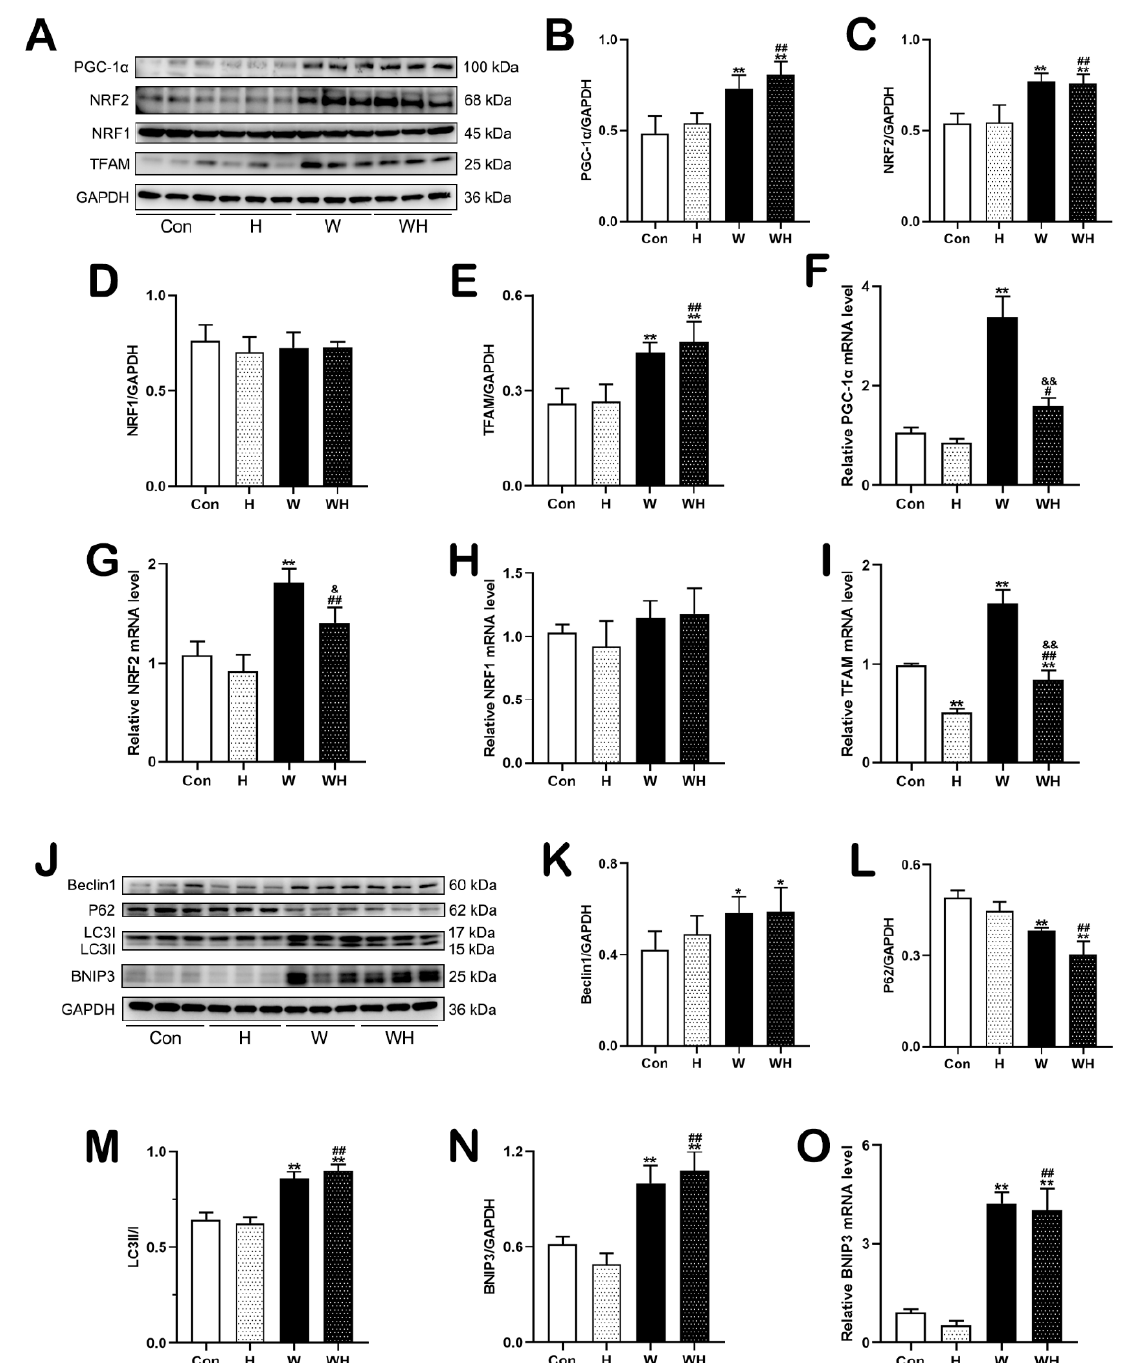
Figure 2. WA enhanced mitochondrial biogenesis and BNIP3-mediated mitophagy in myocardial tissue. ( A – E ) Representative immunoblots ( A ) and statistical graphs of the protein expression of PGC-1 α ( B ), NRF2 ( C ), NRF1 ( D ), and TFAM ( E ). ( F – I ) Relative mRNA levels of genes involved in mitochondrial biogenesis. ( J – N ) Representative immunoblots ( J ) and statistical graphs of the protein expression of Beclin1 ( K ), P62 ( L ), LC3 ( M ), and BNIP3 ( N ). ( O ) Relative mRNA level of BNIP3. The values are presented as the means ± SEMs ( n = 5 animals/group). * p < 0.05 or ** p < 0.01 vs. the Con group. # p < 0.05 or ## p < 0.01 vs. the H group. & p < 0.05, && p < 0.01 vs. the W group.